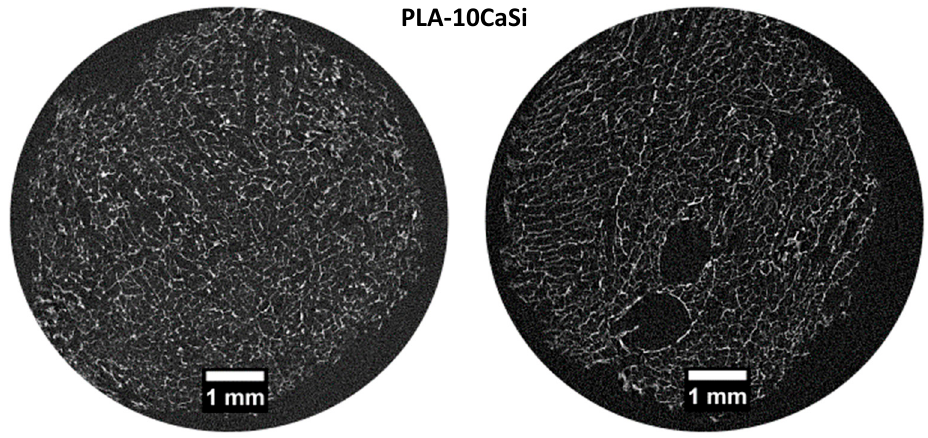
Figure 3. Micro-CT scan of 2 random slices of PLA-10CaSi shows highly porous, more regular “honey-comb” like structure. Small CaSi granules with higher radiopacity may be identified on all the scaffold structure.